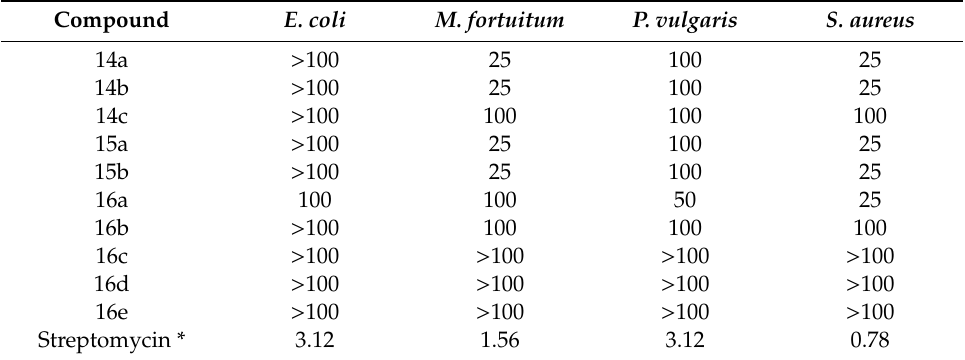
Table 12. MIC of compounds isolated from African Combretaceae from Katerere et al. (2012) [73]. Compound